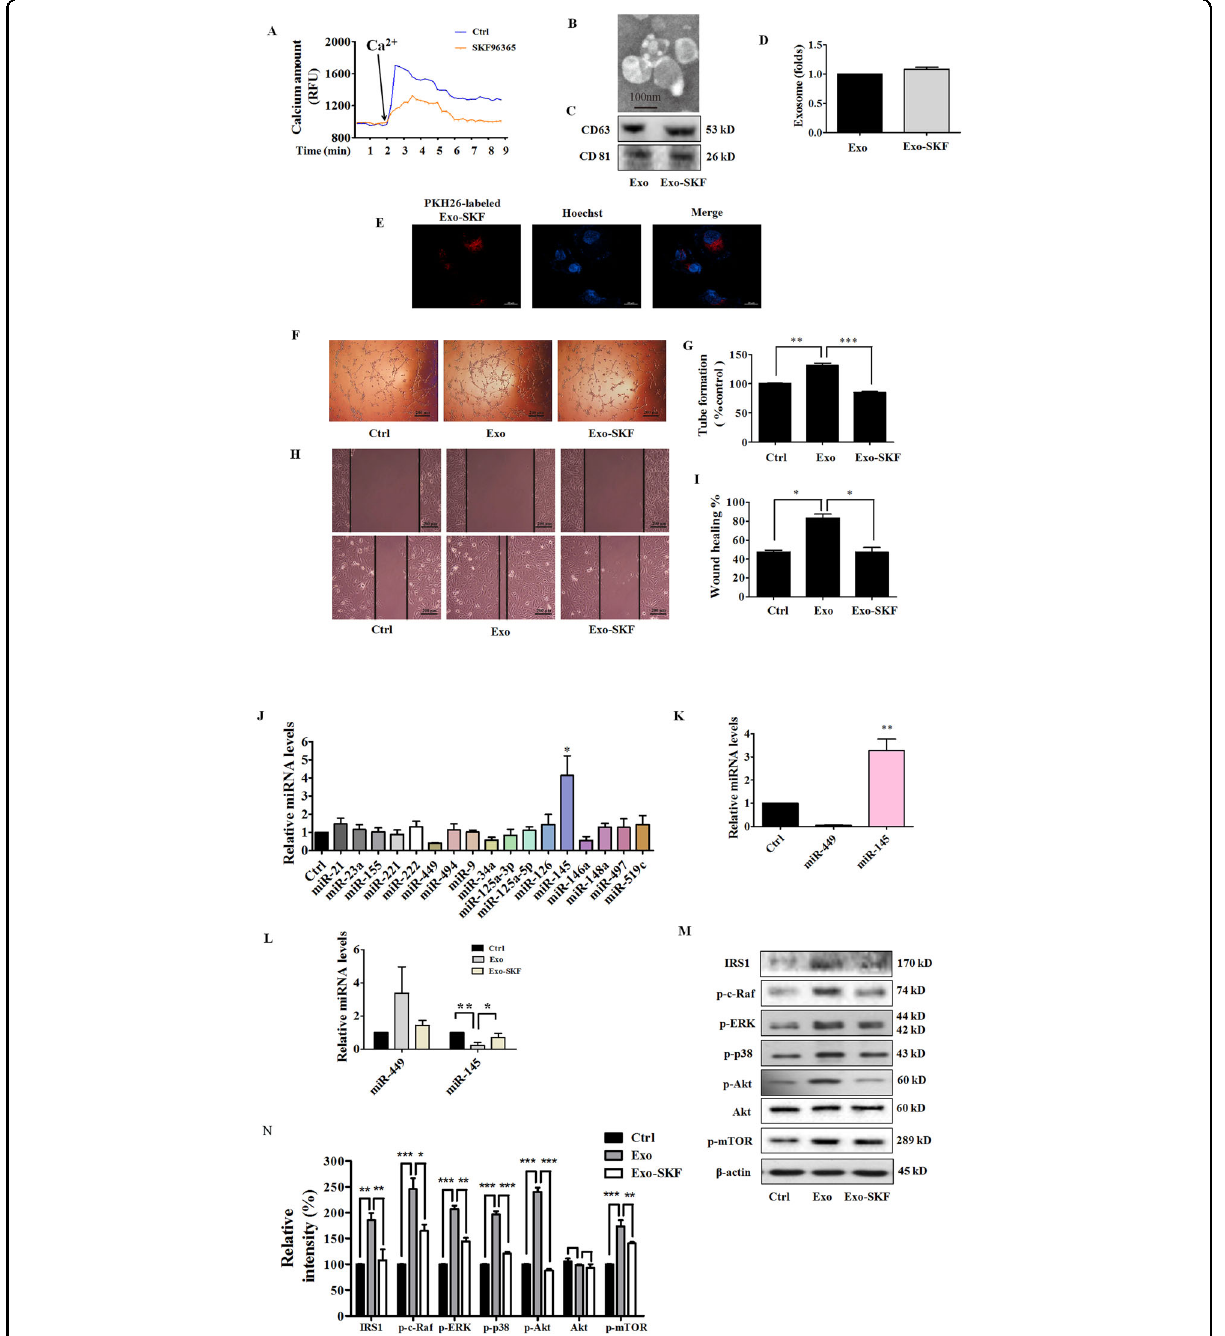
Fig. 3 Exo-SKF inhibits human umbilical vein endothelial cells (HUVEC) tube formation and migration through the miR-145 and IRS1 pathways. A Representative time-course recording of intracellular Ca 2 + fl uorescence showing the inhibitory effect of SKF96365 on Ca 2 + in fl ux in MDA-MB-231 cells, which was determined with FluoForte Calcium Assay Kit. B Representative electron microscopic image of Exo-SKF. MDA-MB-231 cells were treated with 10 μ M of SKF96365. C The markers of exosomes in Exo and Exo-SKF, as determined by western blot. D SKF96365 did not affect the production of exosomes in MDA-MB-231 cells. E The uptake of Exo-SKF in HUVECs. F The Exo-SKF96365 inhibits tube formation in HUVECs. G Quanti fi cation of the results in ( F ). H Exo-SKF96365 reduces HUVEC migration. I Quanti fi cation of the results in ( H ). J Changes of miRNA level in MDA-MB-231 cells were detected by RT-qPCR after treatment with SKF96365. K The relative levels of miR-145 and miR-449 in Exo-SKF. L The relative levels of miR-145 and miR-449 in HUVECs after Exo or Exo-SKF treatment. M The expression of IRS1 and phosphorylation of c-Raf, ERK, p38, Akt, and mTOR in HUVECs after Exo or Exo-SKF treatment. N Quanti fi cation of the results in ( M ). Data represent mean ± SEM from three independent experiments ( n = 3). * P < 0.05, ** P < 0.01, and *** P <